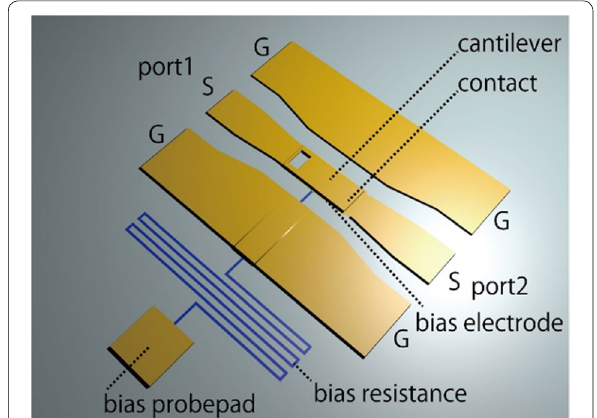
Fig. 1 A schematic view of the ohmic contact type RF‑MEMS switch in coplanar waveguide configuration, which has ground (G)–signal (S)–ground (G)